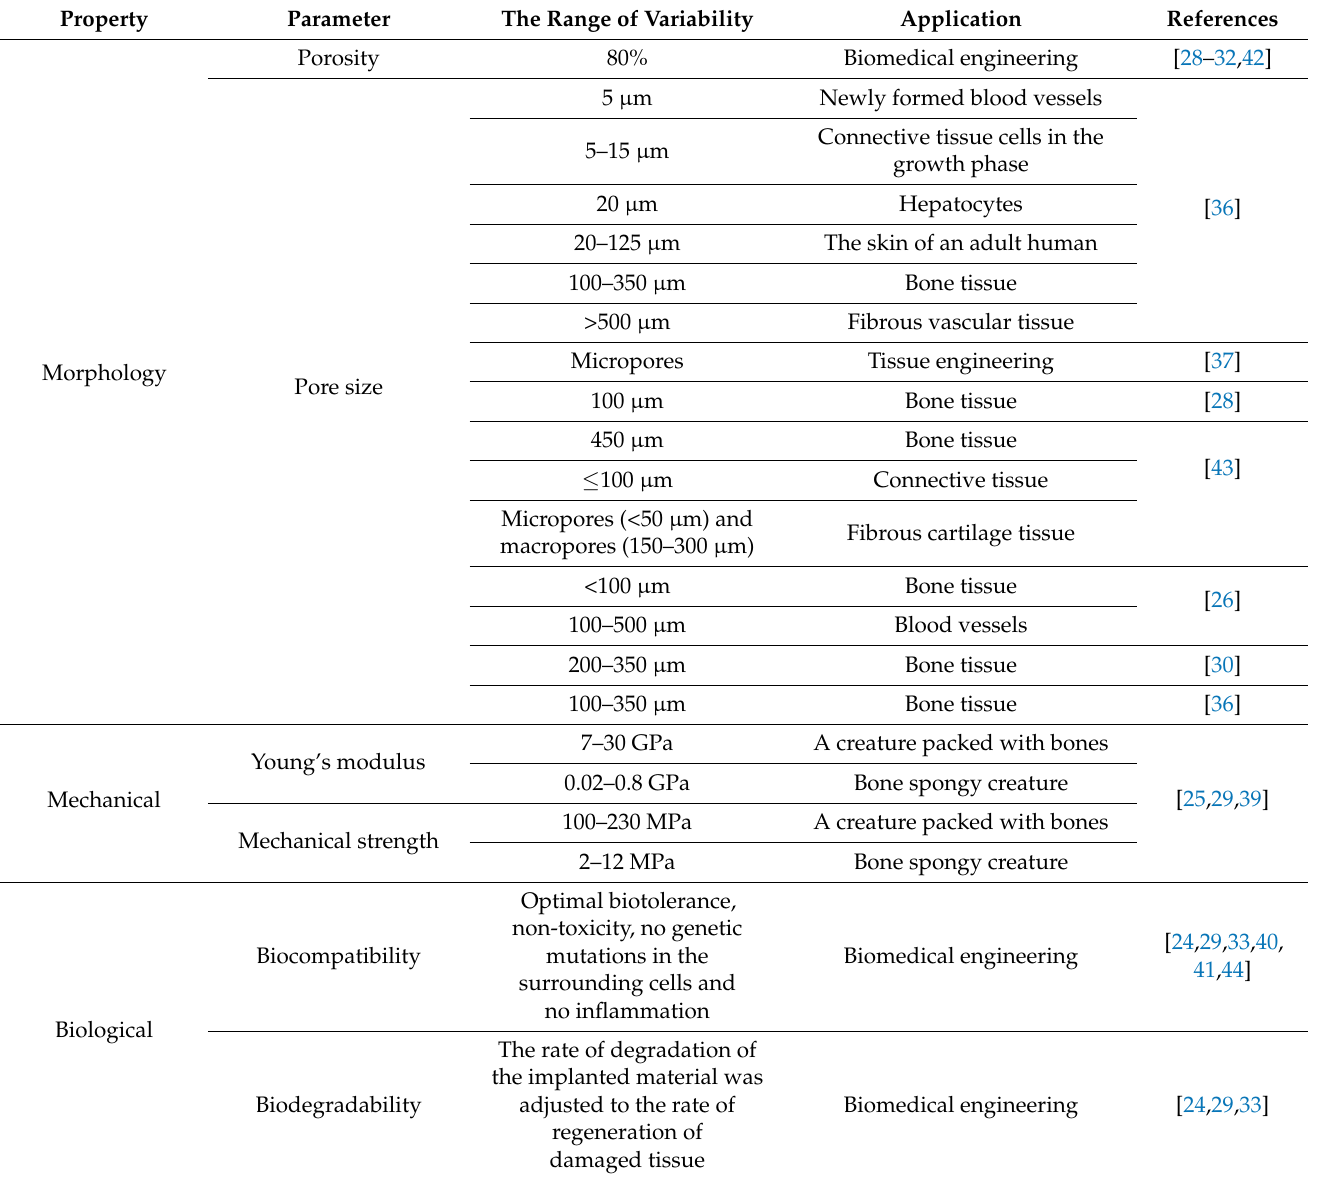
Table 1. Required properties of solid foams for biomedical